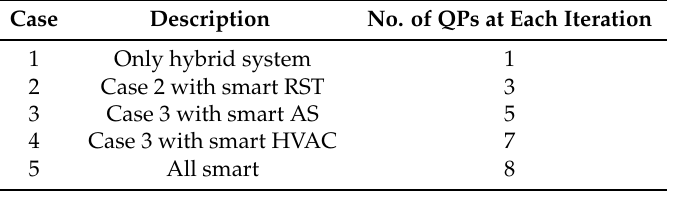
Table 2. Case studies for real-time control. QP, quadratic program.